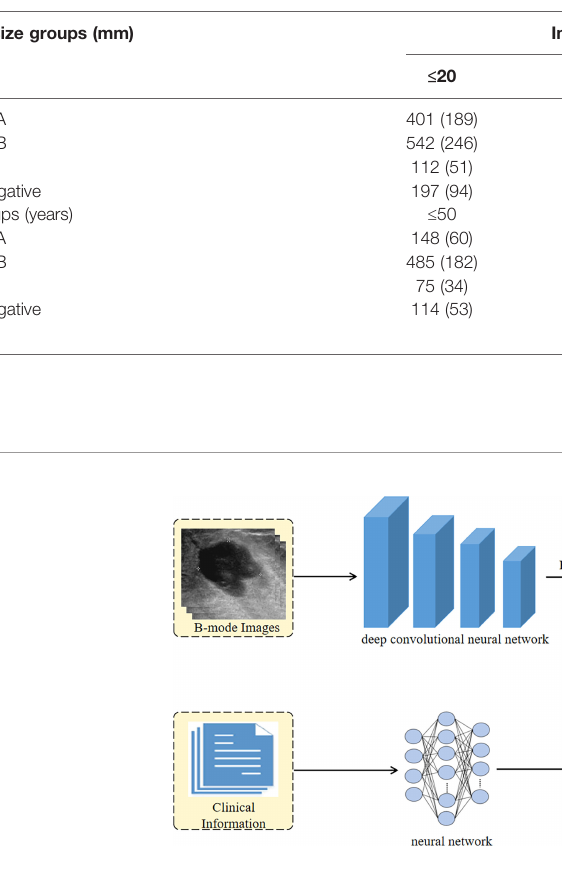
FIGURE 2 | The processing fl ow of our deep convolutional neural network architecture.